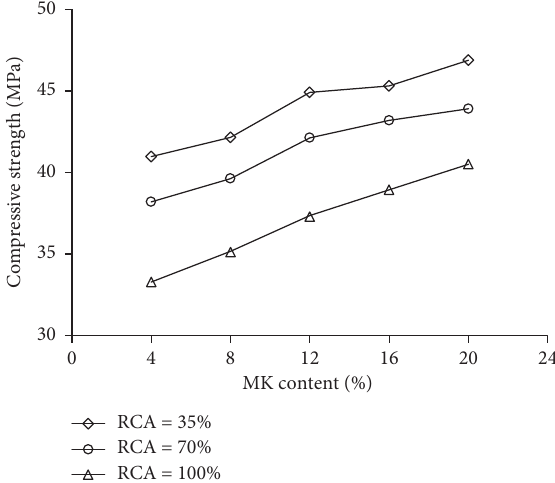
Figure 11: Influence of the MK on the compressive strength of the RCA